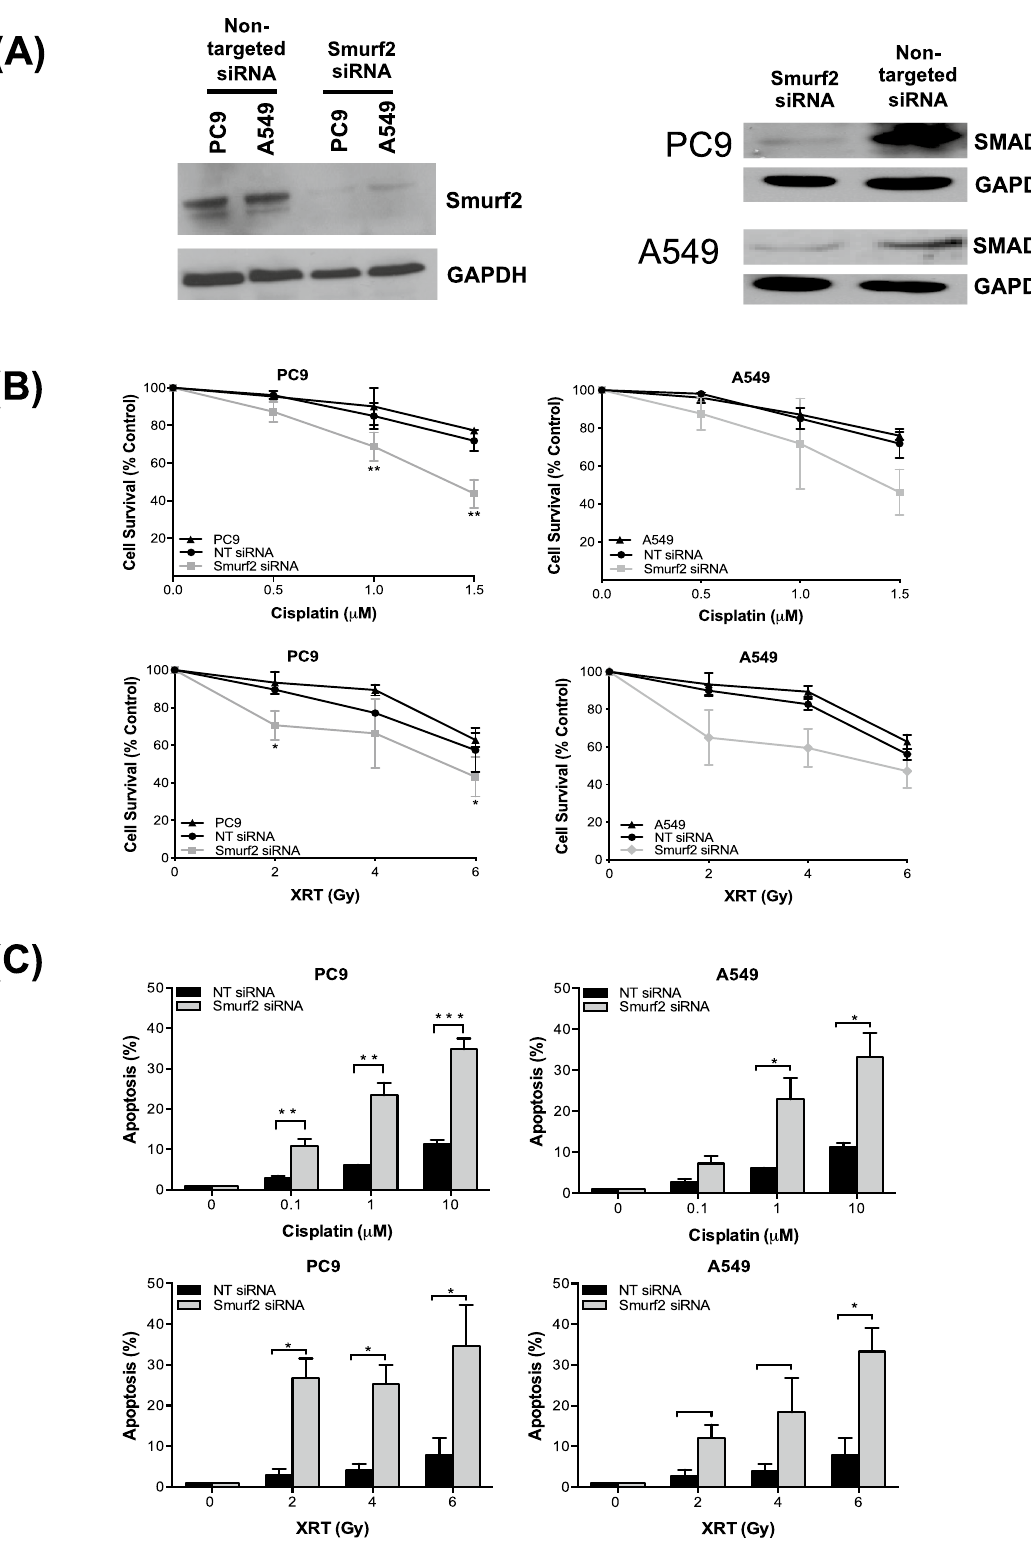
Figure 1. Proliferation and apoptosis analyses of PC9 and A549 NSCLC cells with siRNA-mediated Smurf2 knockdown. Western blot analysis of total Smurf2 and SMAD1 protein levels ( A ) in PC9 and A549 cells after Smurf2 knockdown was confirmed in siRNA-transfected PC9 cells relative to PC9 cells transfected with nontargeting (NT) control siRNA. GAPDH was used as the loading control. Significantly decreased cell survival was observed by MTT assay in Smurf2-knockdown PC9 cells compared to NT siRNA- transfected cells after treatment with increasing concentrations of cisplatin and doses of radiation (RT) ( B ). Quantitative determination of apoptosis in siRNA-mediated Smurf2-knockdown vs. NT siRNA-transfected tumor cells by flow cytometry after treatment with increasing concentrations of cisplatin and doses of radiation ( C ). PC9 and A549 cells were colabeled with FITC-conjugated annexin V (AV) and PI. * p < 0.05; ** p <